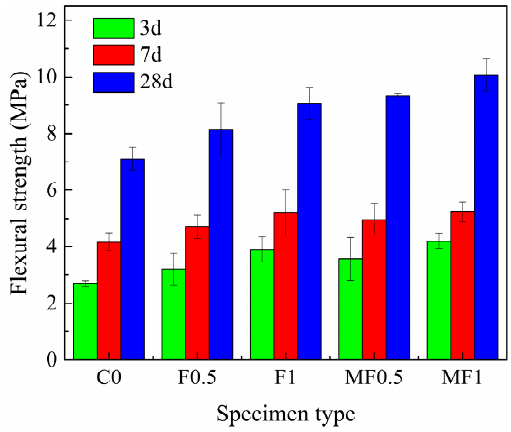
Figure 8. Flexural strength of cement specimens for di ff erent curing